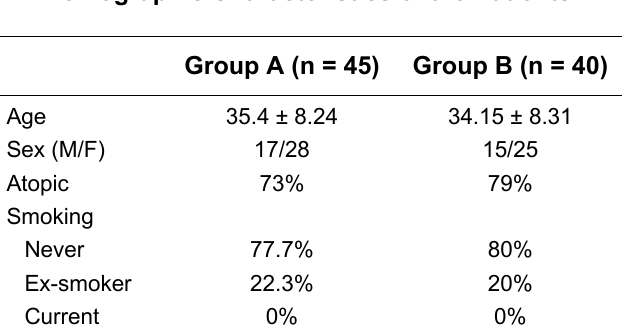
Demographic Characteristics of the